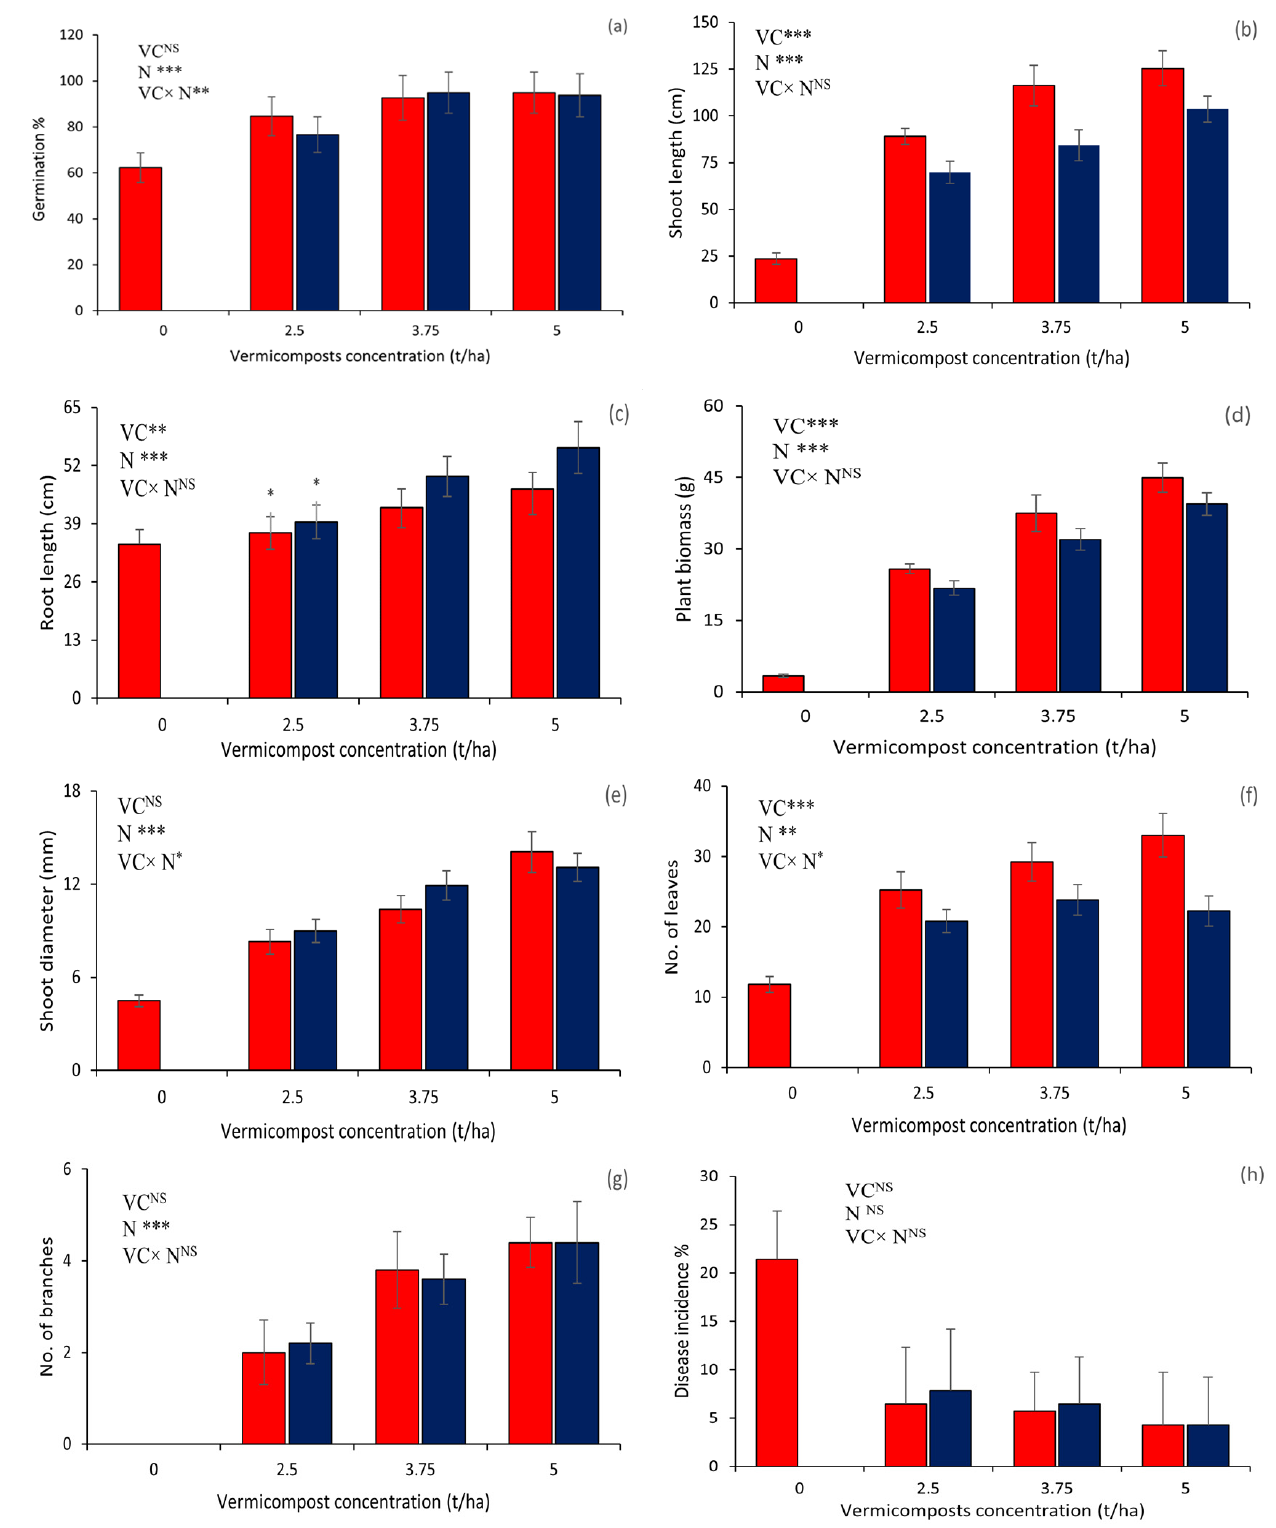
Figure 1. Effect of LVC and CDVC on ladies fingerin terms of ( a ) germination success; ( b ) length of shoots; ( c ) length of roots; ( d ) plant biomass; ( e ) shoot diameter; ( f ) number of leaves; ( g ) number of branches; and ( h ) disease incidence. All the bars carry range of standard deviation. Bars topped with an asterisk indicate that the corresponding numbers do not differ significantly from the controls at p ≤ 0.05. N indicate the vermicompost treatments. In comparison to CDVC, the shoot length and the plant biomass were significantly higher in the ladies finger plant grown in LVC amended soil; however there was no sta ‐ tistically significant difference vis a vis shoot diameter and the number of branches. As elucidated by Hussain and Abbasi [18], vermicompost amendment in soil enhances the available nutrient content of the soil, besides making the soil porosity, density, and water holding capacity more plant ‐ friendly. In addition, soils amended with vermicomposts were seen to be rich in fulvic and humic acids, and plant hormones [34], which appar ‐ ently boost the growth of plants compared to the controls. The results of the present in ‐ vestigation show that in some aspects LVC has outperformed CDVC while in some other aspects no significant difference was seen between the two. This makes it evident that lantana loses its toxic and allelopathic constituents during its vermicomposting and the resultant vermicompost, has positive influence on the growth of ladies finger. Equally significant is the finding that the positive influence matches—at times even surpass ‐ es—that of CDVC. 3.3. Yield and Biochemical Aspects Vermicompost treatments are seen to have significantly enhanced the yield of the ladies finger pods as reflected in the average numbers and weights of pods per plant, and the average length and diameter of the pods (Table 2). In comparison to the CDVC, LVC had significantly higher number of pods per plant. It also led to pods of higher average weight. However, no significant difference was seen in case of length and diameter of the pods. Vermicompost treatments had also significantly increased the concentrations of chlorophyll and carotenoids in the ladies finger leaves, and the total solids and ash con ‐ tent of its fruits in comparison to the control plots (Figure 2a–d). No statistically signifi ‐ cant difference, however, was seen between the LVC and the CDVC in terms of influence on chlorophyll, carotenoids, total solids, protein and carbohydrates content (Figure 2e–f). These gains, like the plant growth parameters, can perhaps be attributed to the increased plant available nutrients in soil fortified with vermicomposts, compared to the controls. This is consistent with similar e ff ect reported when manure − based vermicomposts were deployed [35,36]. Overall, LVC appears to be as beneficial for the cultivation of ladies finger as CDVC. 3.4. Disease Incidence Both the vermicomposts were able to induce disease resistance in the test plants (Figure 1h, Table 2). In terms of reducing the incidence of disease, LVC has performed marginally better than CDVC; however, the difference was not statistically significant. The fractions of infected fruits was lesser in CDVC treatments of 3.75 and 5 t ha − 1 than in the corresponding LVC applications. However, again, the difference was not statistically significant. In a recently published review, Hussain and Abbasi [18] have documented a number of scientific studies reporting the positive role of manure ‐ based vermicomposts in reducing pests and disease in several botanical species. The present work shows that LVC also possesses a similar virtue. Previous reports on pathogen ‐ protecting attribute of manure–based vermicomposts reveal that better nutrient availability, and presence of antimicrobial compounds such as flavonoids, phenols and humic acids in the vermicomposts, are the likely factors that may have imbibed the vermicomposts with the ability to resist pathogens [37]. Evidently these beneficial attributes are also present in LVC.